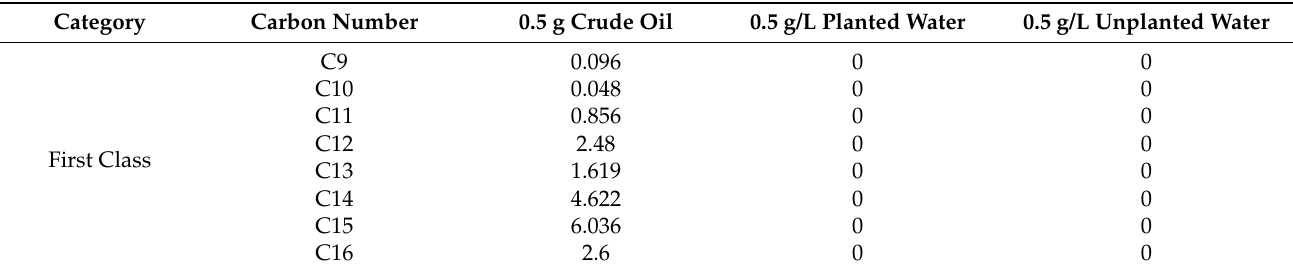
Figure 3. Histograms abundance of different normal paraffins of the saturated hydrocarbon fractions analyzed at 0.5 g crude oil before use ( a ), after a 7-daygrowth period in 0.5 g/L polluted unplanted water ( b ) and planted polluted water with the A-A combination ( c ). Table 2. Relative quantitative GC analysis of the n-paraffinic saturated compounds (% of TSHs) extracted from oil-polluted freshwater after 7 days of growth of the A-A combination following exposure to 0.5 g/L crude oil pollution. The results are compared with their initial and residual amounts in crude oil and the polluted unplanted control,